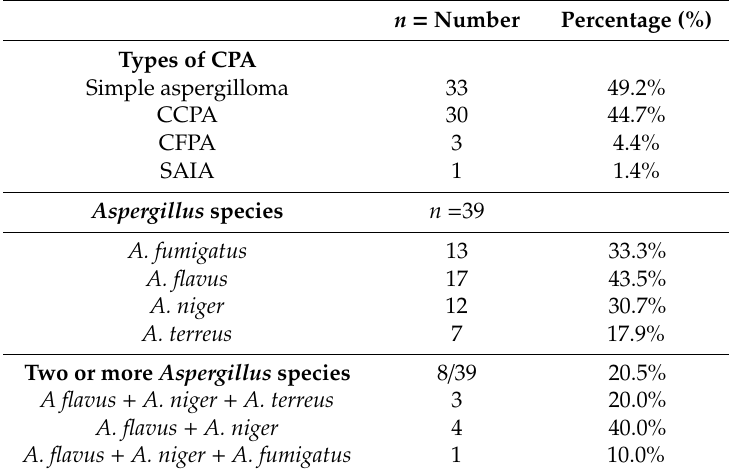
Table 2. Type and microbiological features for patients with